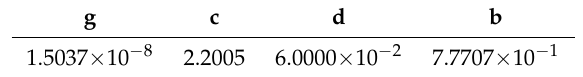
Figure 7. SFMR-estimated κ r (using the new EEW model) as a function of collocated HRD rain rate. Table 4. New Coefficients of the Model for Rain Absorption Above 10mmh − 1 .